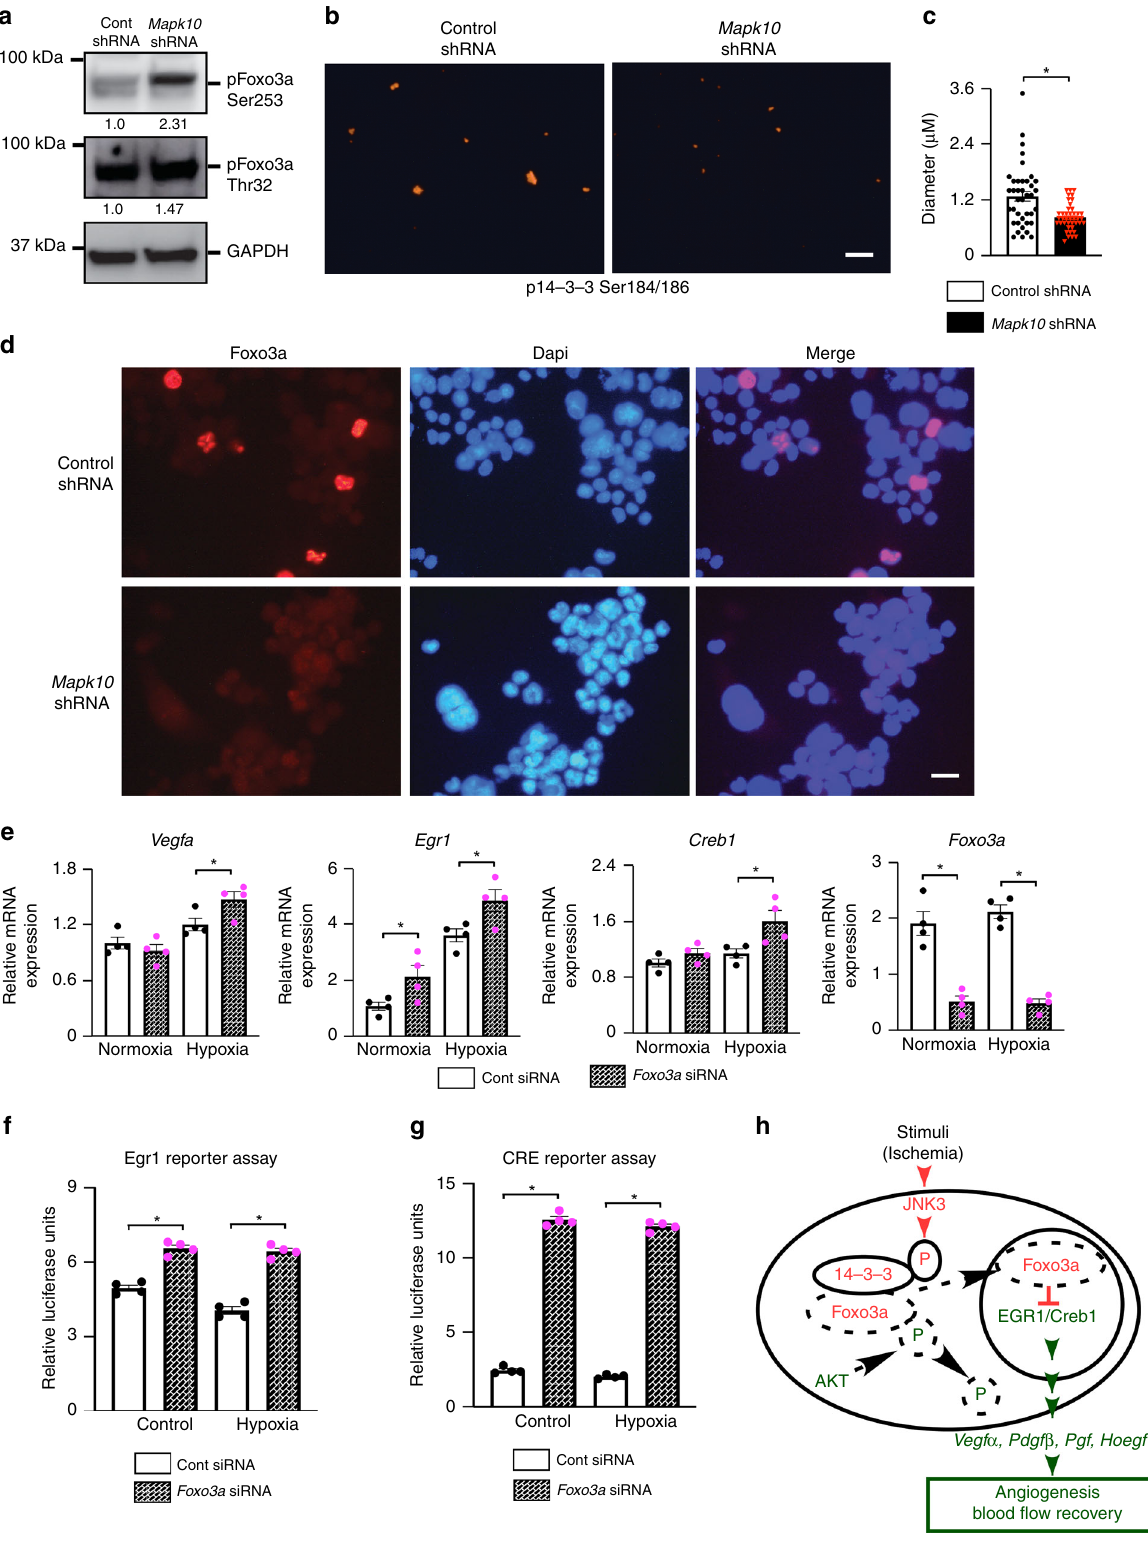
30s rest period to allow for poloxamer drying. After the gene painting and brief drying period, the wound was closed. Post-surgery mice were given a recovery period up to a week to allow for reduced in fl ammation. Tissues were harvested and gene expression was analyzed by qRT-PCR. Cell culture and transfections . Mus musculus brain neuroblastoma cell line Neuro-2a (#CCL-131) was purchased from ATCC and cultured in Dulbecco ’